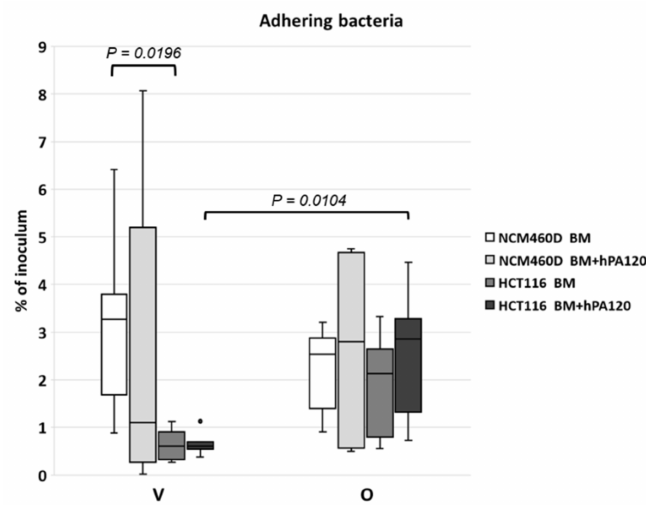
Figure 2. Percentage of adherent bacterial cells (%ADH) to the healthy (NCM460D) and cancer (HCT116) colonocytes. Fecal bacteria derived from vegan (V) and omnivorous (O) volunteers were grown in Wilkins–Chalgren medium supplemented with 0.5% of mucin and 1 mM of phytic acid for 42 h at 37 ◦ C in an anaerobic atmosphere. The adhesion assay was performed with bacteria alone (BM) or with bacteria and the hydrolysate of phytic acid (BM + hPA120), for 2 h at 37 ◦ C. Whiskers— non-outliers, box—25–75% non-outliers; horizontal line in the box—median; black dot—outliers. Significant differences were calculated with the Mann–Whitney U